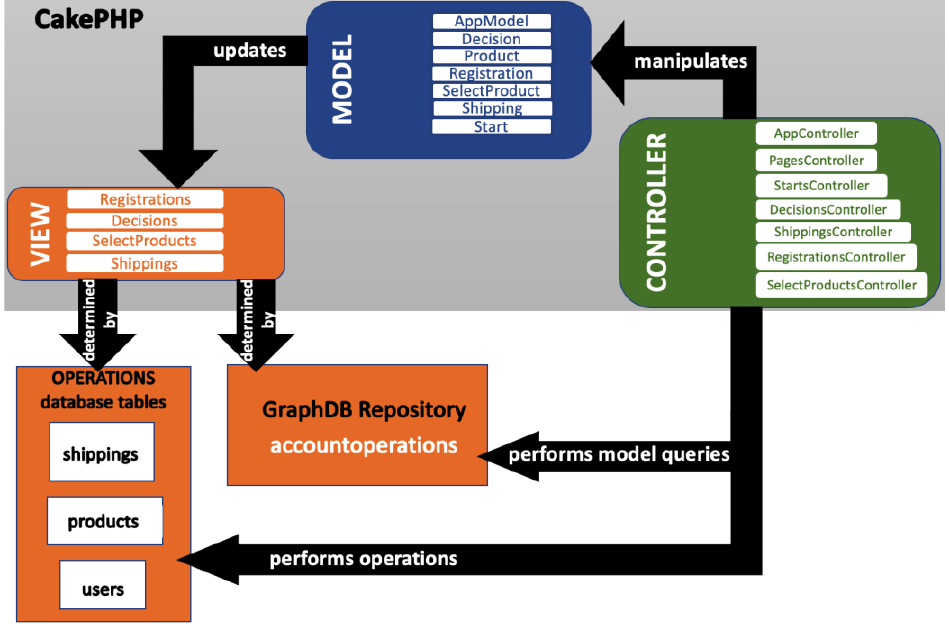
Figure 3. CakePHP architecture connected to MySQL database and